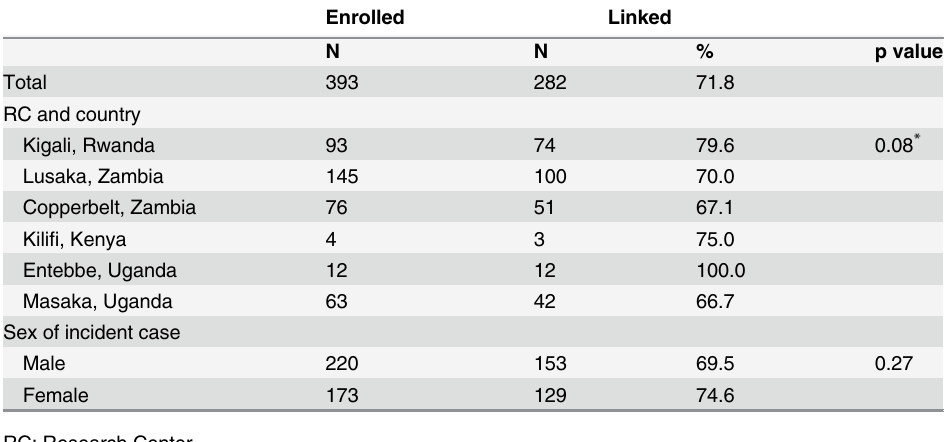
Table 4. Number of volunteers with HIV sequence data who enrolled with their suspected partner and were epidemiologically